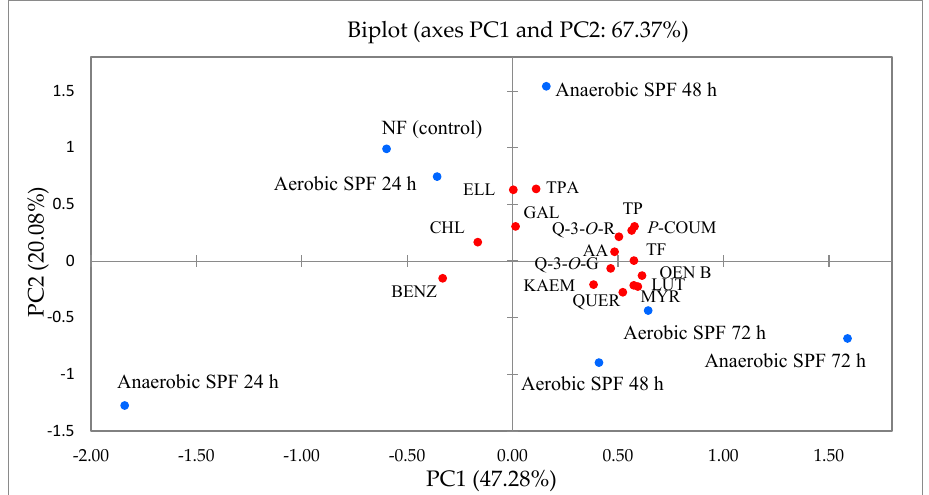
Figure 3. Principal component analysis of flavonoids, phenolic acids, oenothein B (tannin) and antioxidant activity in fireweed leaves samples fermented under the different fermentation methods and different fermentation duration, based on 16 variables. Variables: total polyphenols (TP), total phenolic acids (TPA), ellagic acid (ELL), gallic acid (GAL), chlorogenic acid (CHL), p -coumaric acid ( P -COUM), benzoic acid (BENZ), total flavonoids (TF), quercetin-3- O -rutinoside (Q-3- O -R), myricetin (MYR), luteolin (LUT), quercetin (QUER), quercetin-3- O -glucoside (Q-3- O -G), kaempferol (KAEM), oenothein B (OEN B) and antioxidant activity (AA). Conditions of fermentation: fermentation method (aerobic solid-phase fermentation method (Aerobic SPF), anaerobic solid-phase fermentation method (Anaerobic SPF), not fermented (NF)) and their different duration (Not fermented (NF), fermented 24 h, 48 h and 72 h).